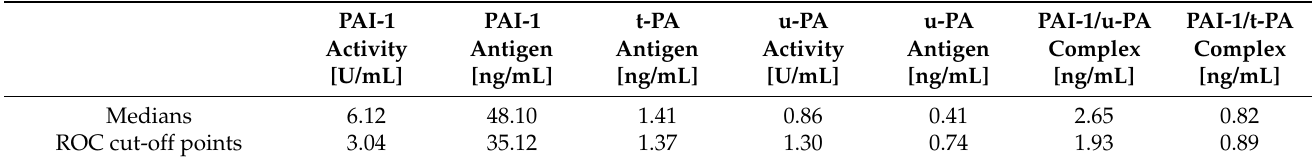
Table 5. Calculated median and ROC cut-off point values of investigated fibrinolytic